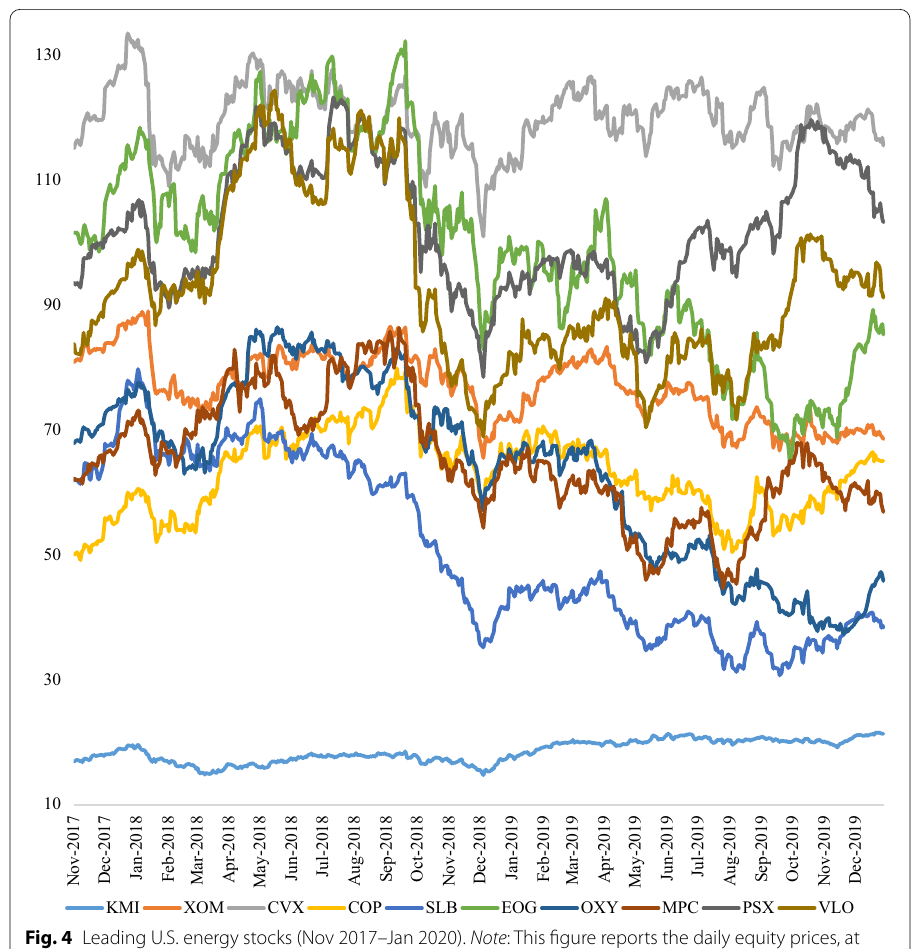
Fig. 4 Leading U.S. energy stocks (Nov 2017–Jan 2020). Note : This figure reports the daily equity prices, at close, for the ten energy companies, which are all listed as leading stocks under the S&P 1500 Composite Energy index. The stocks (trading symbols) include Kinder Morgan Inc (KMI), Exxon Mobil (XOM), Chevron Corp (CVX), ConocoPhillips (COP), Schlumberger Ltd (SLB), EOG Resources (EOG), Occidental Petroleum (OXY), Marathon Petroleum Corp (MPC), Phillips 66 (PSX), and Valero Energy Corp (VLO). The data covers the period Nov 2017–Jan 2020. Source : S&P 500 Dow Jones Indices,